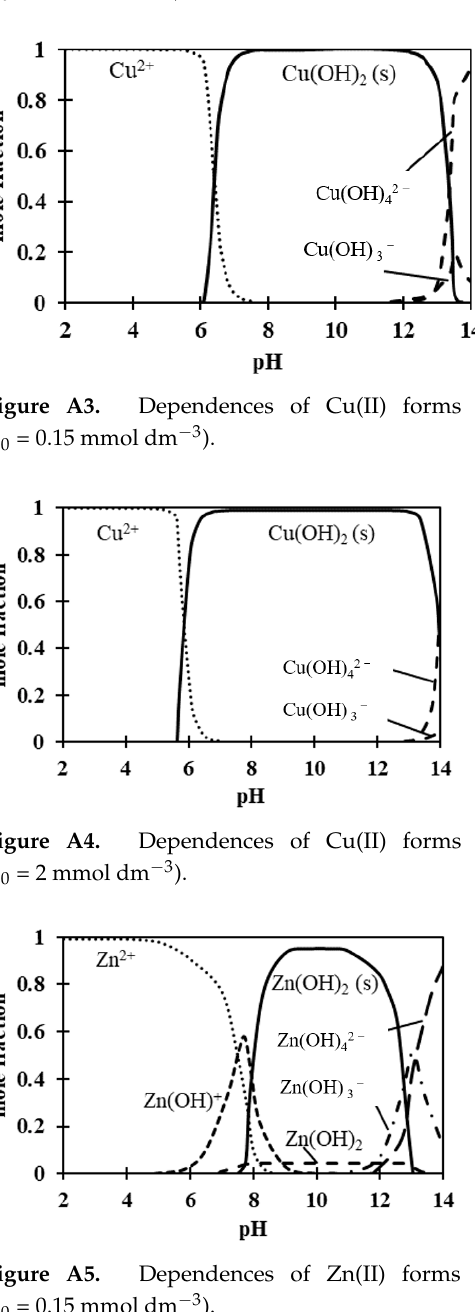
Figure A6. Dependences of Zn(II) forms on the pH value of the aqueous solutions (c 0 = 2 mmol dm − 3 ).